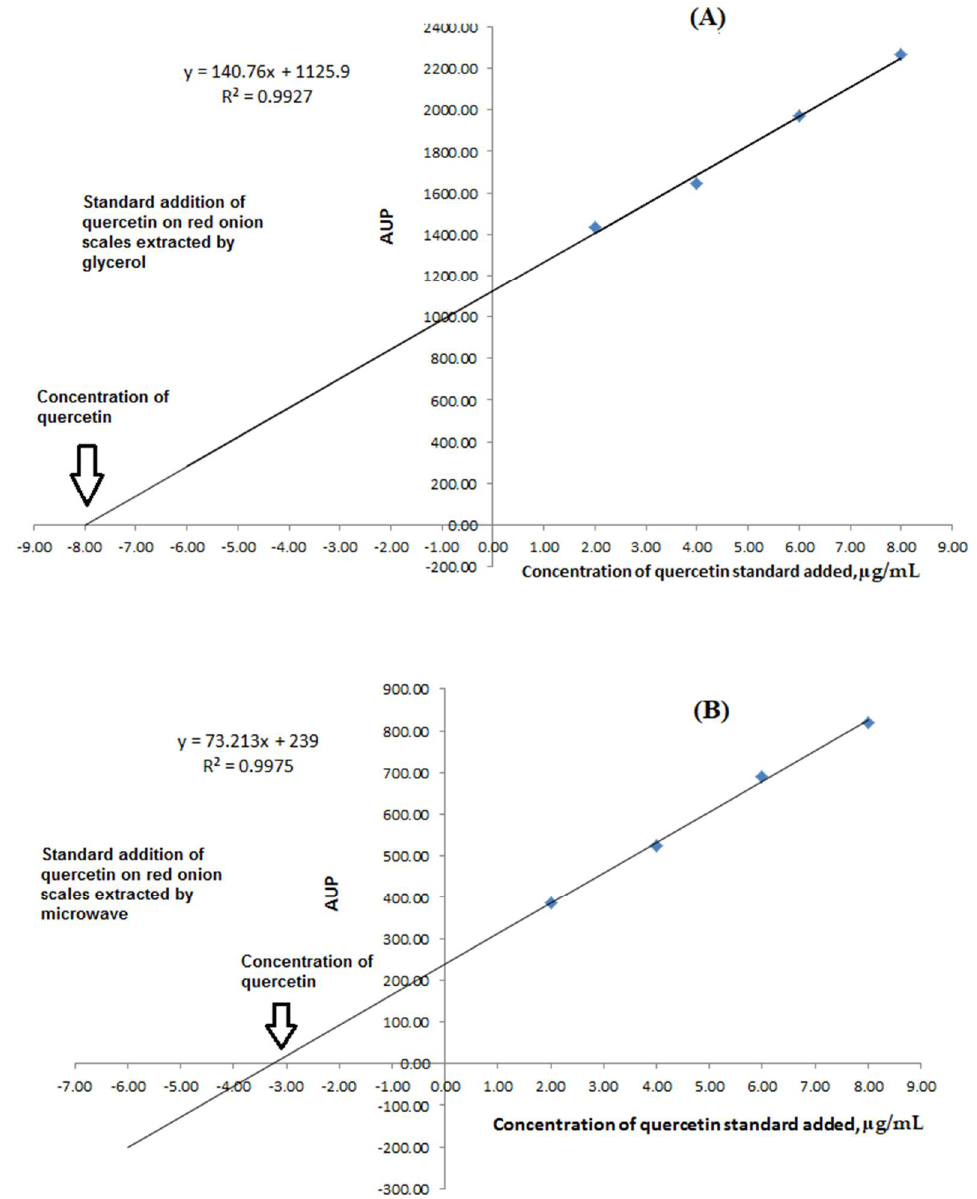
Figure 4. Graphs showing matrices effect and the calculation of quercetin concentrations using the standard addition technique for: ( A ) Ultrasound-assisted glycerol extraction for the extraction of red onion scales and ( B ) microwave aided extraction for the extraction of red onion scales.